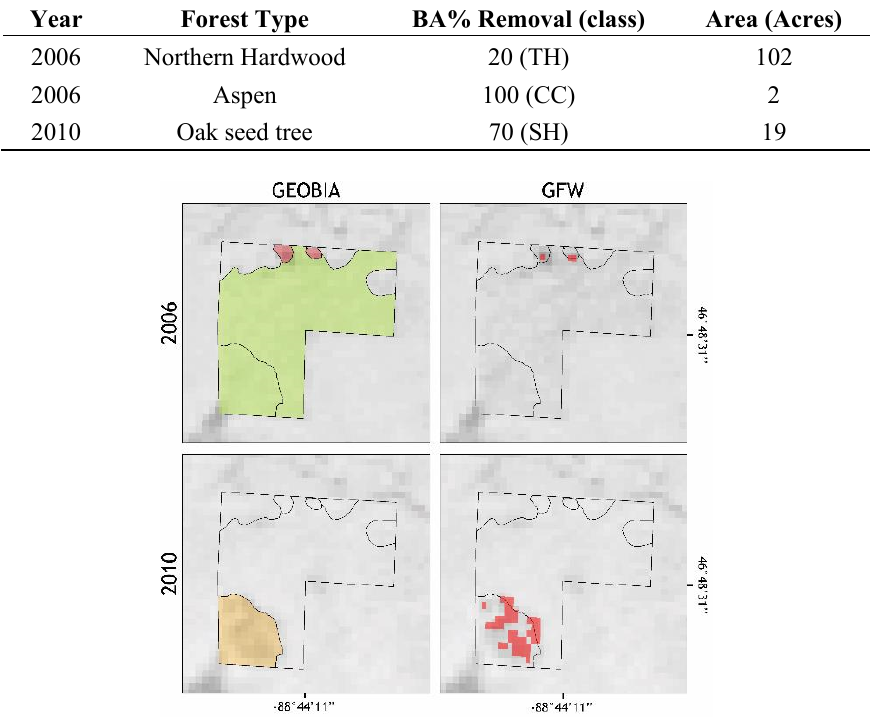
Figure 5. Comparison of OBCD and Global Forest Watch vegetation loss detection in the VU in 2006 and 2010, overlaid onto the corresponding NDVI image. Legend in accordance with Figures 3 and 4, respectively.